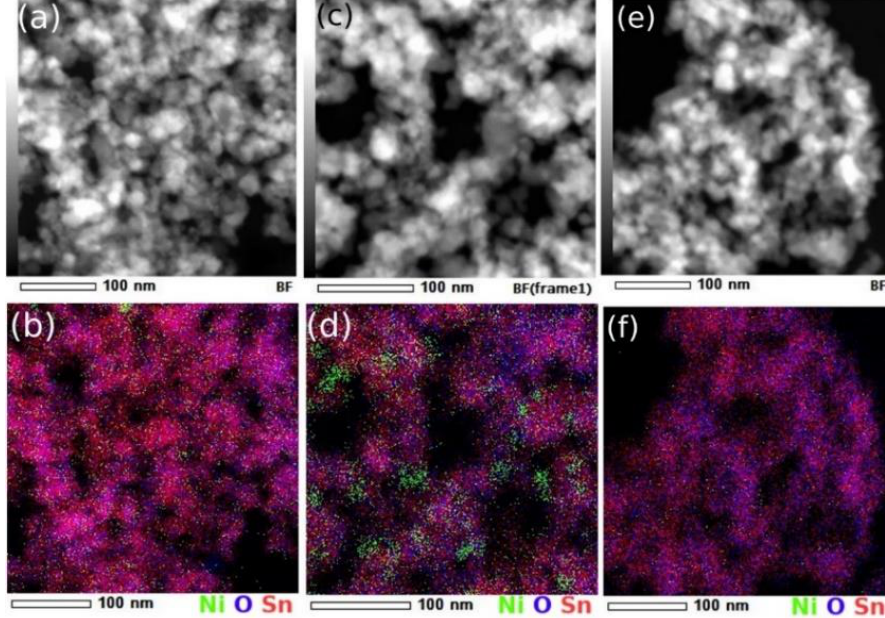
Figure 5. Dark-field STEM and EDS chemical map for SnO 2 +1%NiO ( a , b ), SnO 2 +10%NiO ( c , d ) as compared with SnO 2 reference ( e , f ).